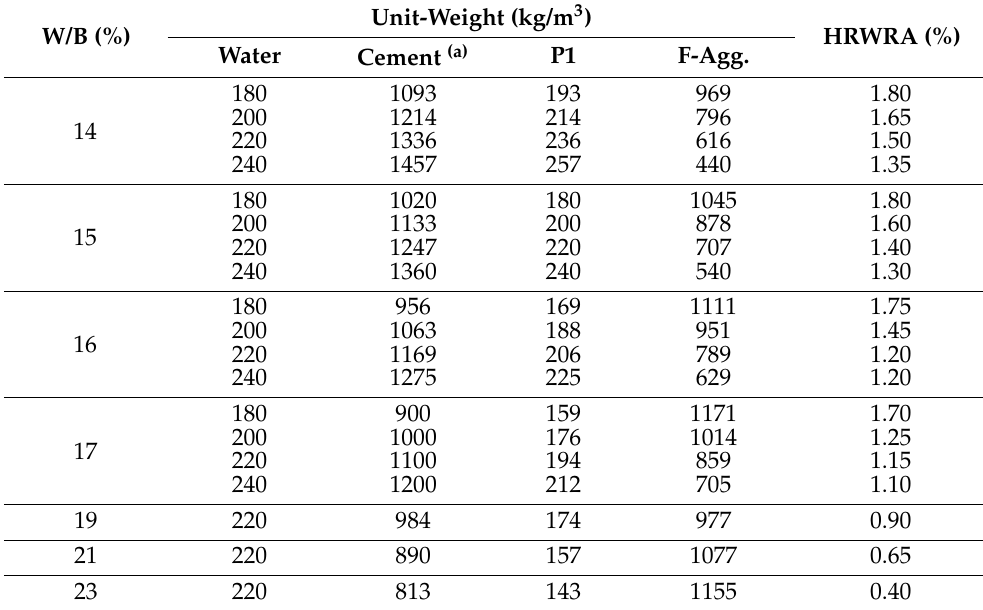
Table 4. Mixture proportions of base mortar (a test for the effects of W/B and water content).